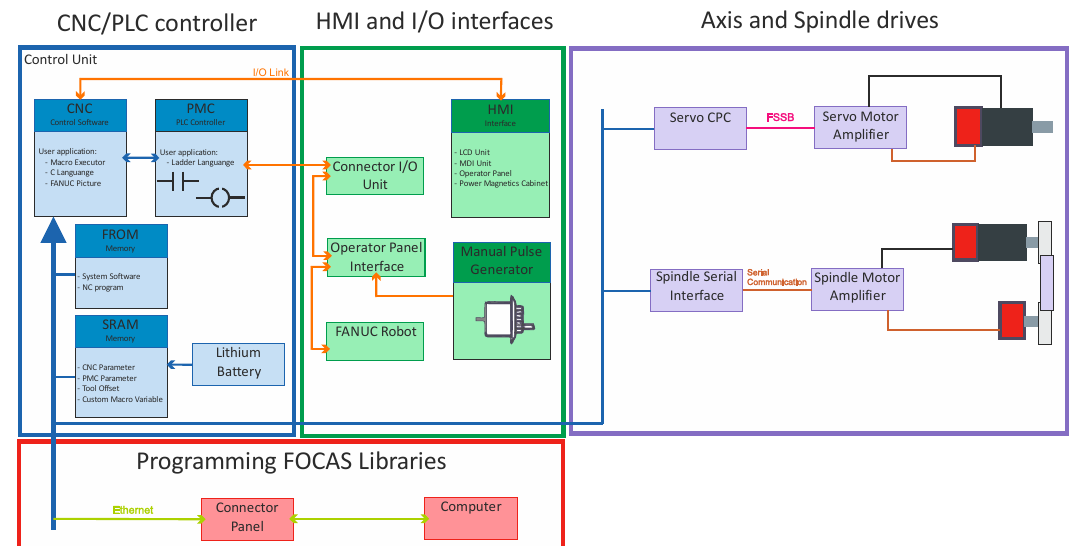
Figure 6. Structure of the Fanuc CNC control system.